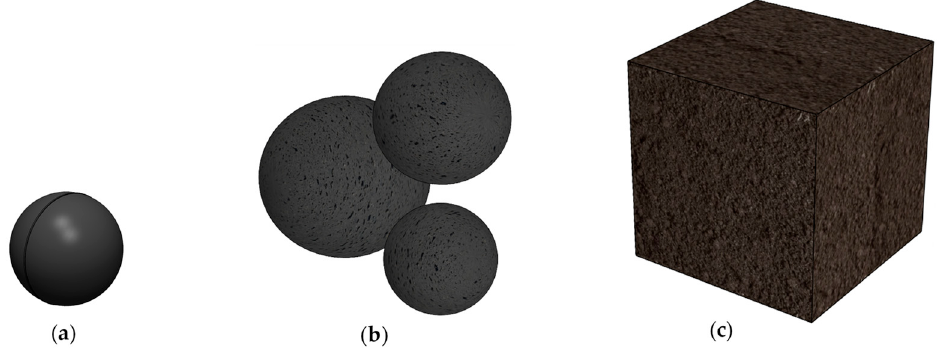
Figure 4. Pelleted and briquetted seeds: ( a ) Calibrated spherical pelleted seed; ( b ) Uncalibrated spherical or ellipsoidal pelleted seed; ( c ) Square briquetted seed.